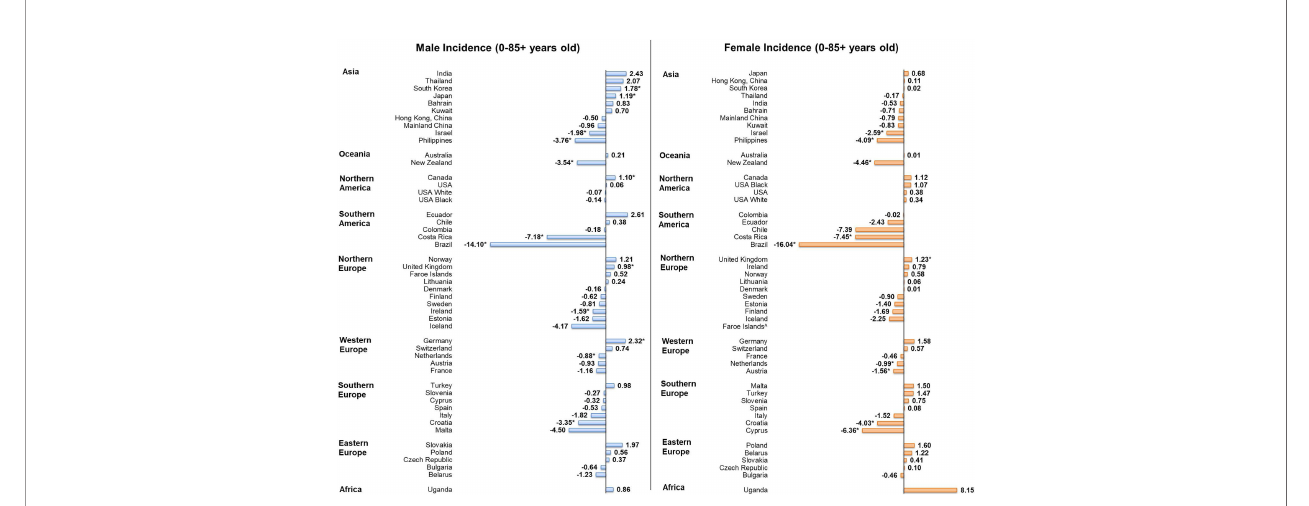
FIGURE 4 | AAPC of incidence of leukaemia in individuals aged 0 – 85+ years old. * p values < 0.05.